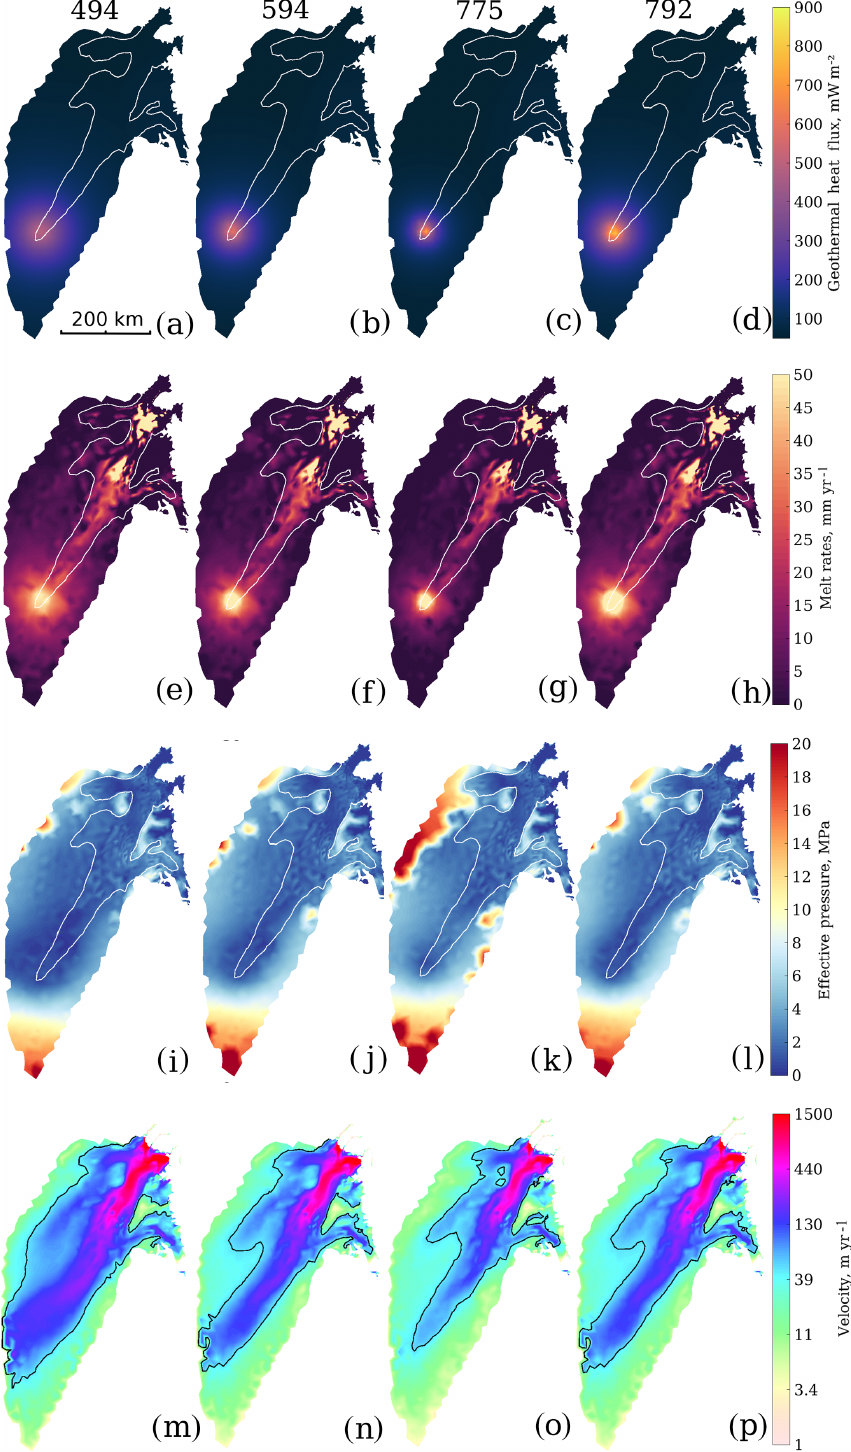
Figure 4. Model results from the sensitivity simulations investigating a reduced magnitude and increased size of the mantle plume. The first column shows results from the 494 plume with a 300km radius at 3000km depth, the second column represents the 594 plume with a 200km radius and 2500km depth, the third column represents the 775 plume with a 100km radius and 2000km depth, and the last column represents plume 792 with a 200km radius and 3000km depth. Panels (a–d) show the GHF, (e–h) the resulting basal melt rates, (i–l) the computed effective pressure and (m–p) the modelled surface velocity. White lines show the 50myr − 1 observed velocity contour, and black lines show the 50myr − 1 modelled velocity